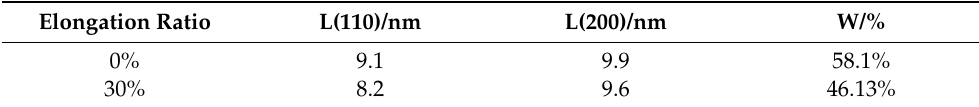
Table 1. XRD parameters of polyethylene after tensile treatment at different